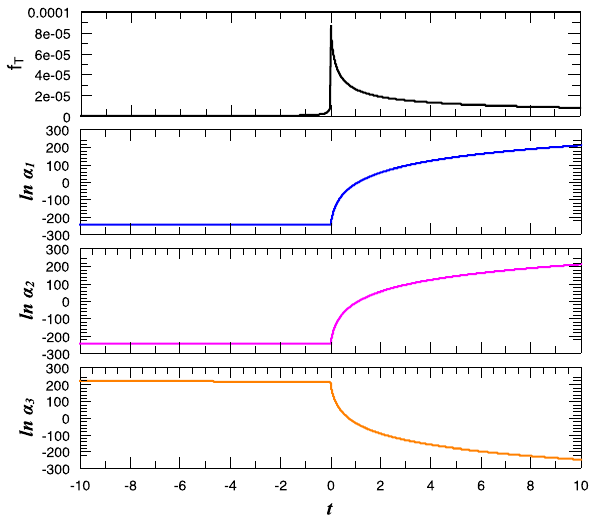
Fig. 1 From top to bottom are the plots of f T , α 1 , α 2 and α 3 respec- tively, with respect to cosmic time t , while t = 0 is the bounce point. Note that all these parameters are positive ( α i ’s are plotted in Logarithm scale.) while f T presents a sharp peak. The parameters are chosen as: